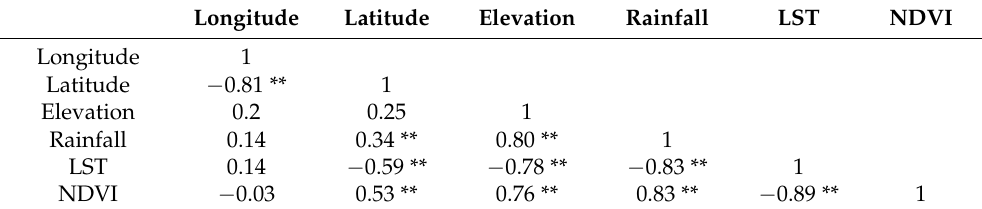
Figure 8. The spatiotemporal distribution of annual precipitation (mm/year) in IKR during the period 2008–2017. Table 5. Pearson correlation between NDVI, LST, and ecological parameters.